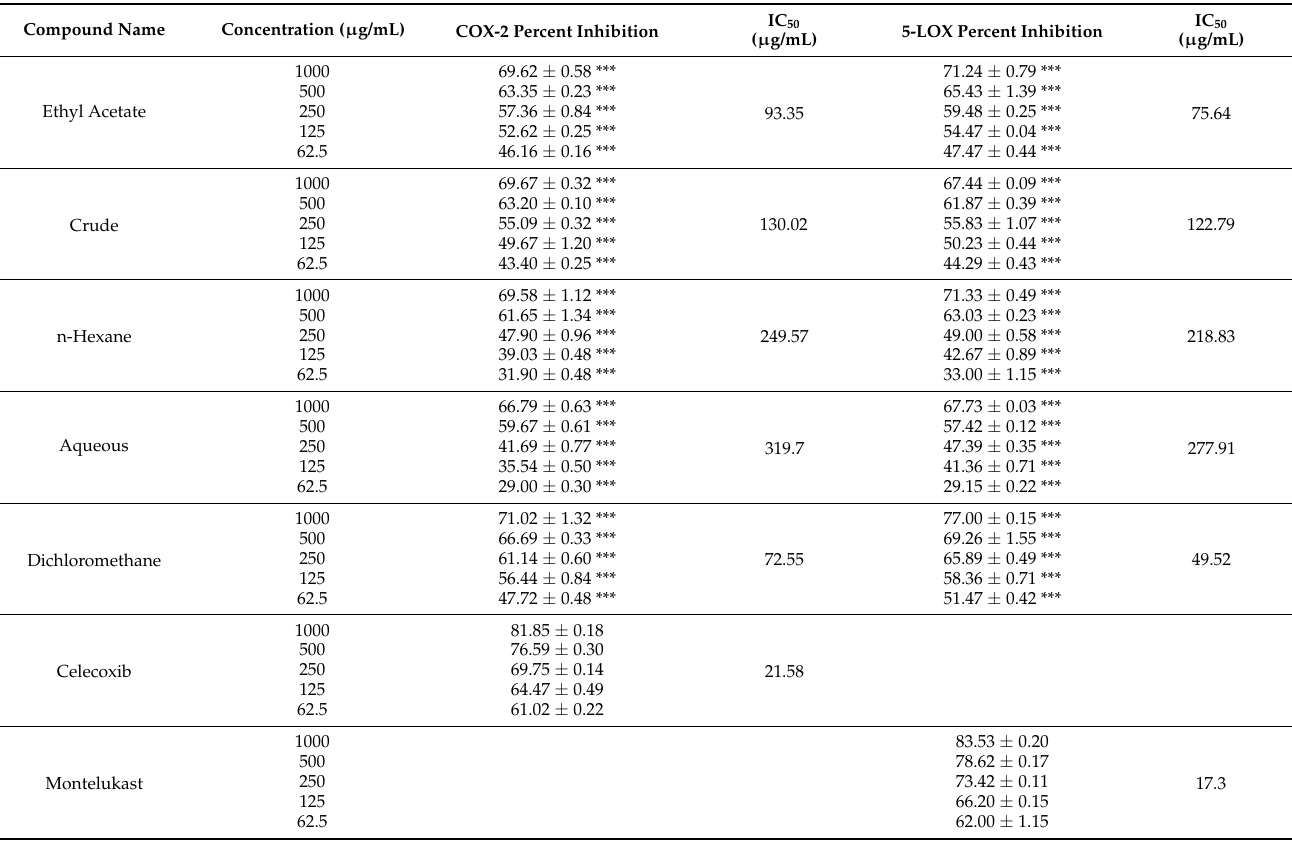
Table 3. COX-2 and 5-LOX inhibitory assay of the crude extract and different fractions of C. macrophylla .